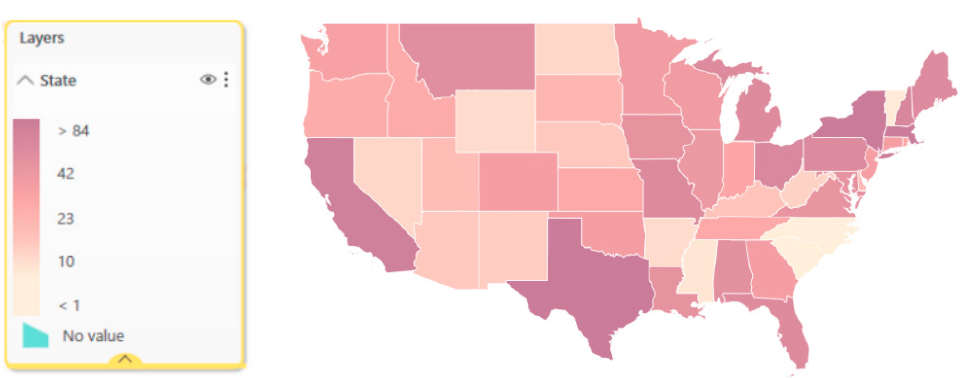
Figure 3. Participation in the RRN by U.S. State (excluding Hawaii and Alaska).